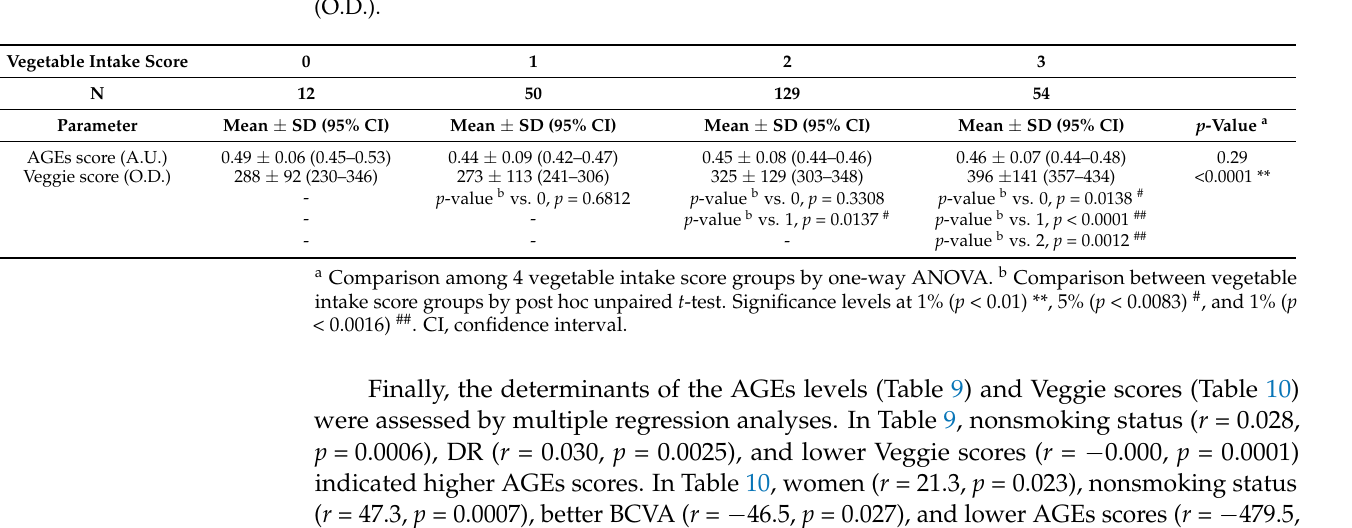
Table 8. Possible associations of vegetable intake scores with AGEs scores (A.U.) and Veggie scores (O.D.).